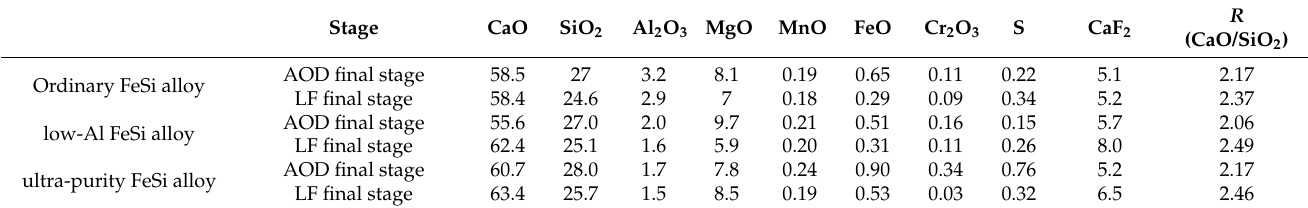
Table 3. Chemical composition of refining slag during the test